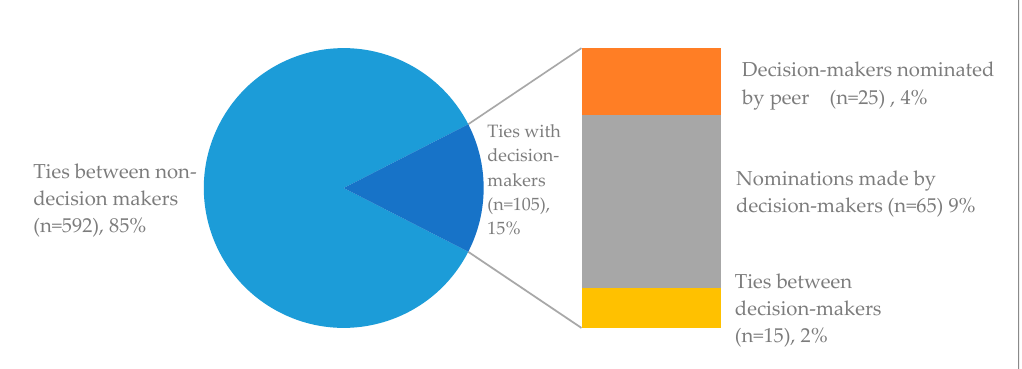
Figure 6. Direct relationships with decision-makers as share of total direct ties in the network. The right